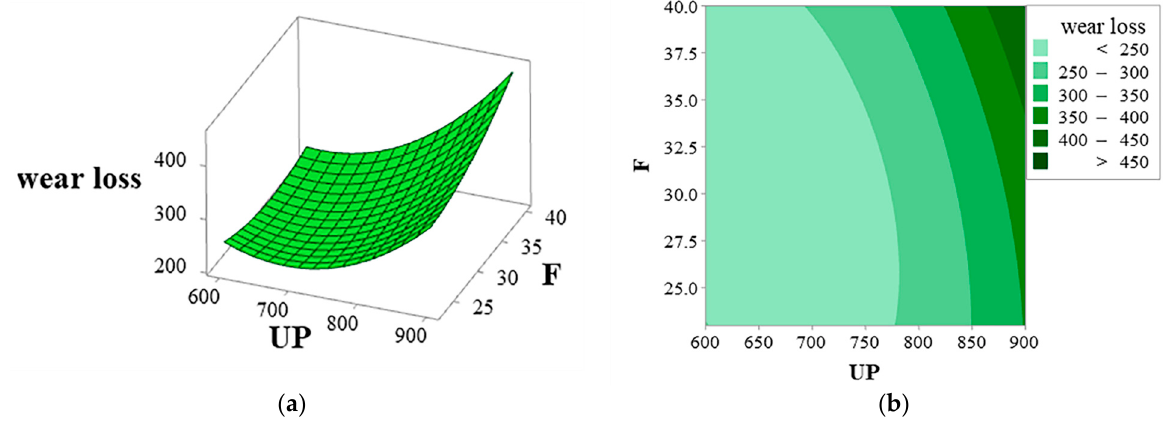
Figure 16. Interaction diagram of UP and F: ( a ) surface diagram and ( b ) contour diagram.